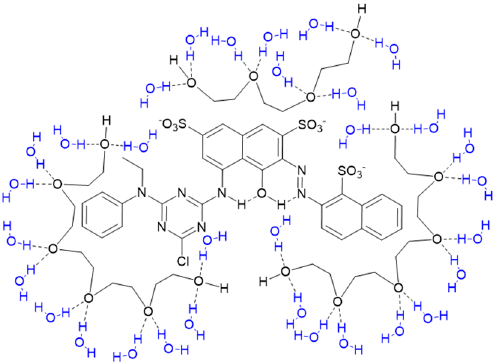
Figure 2. Visible absorption spectra of 7% Red 218 and PEG solutions at 25 °C. ( a ) For different amounts of PEG400; ( b ) For PEG200, PEG400, and PEG600 at 30% by weight.